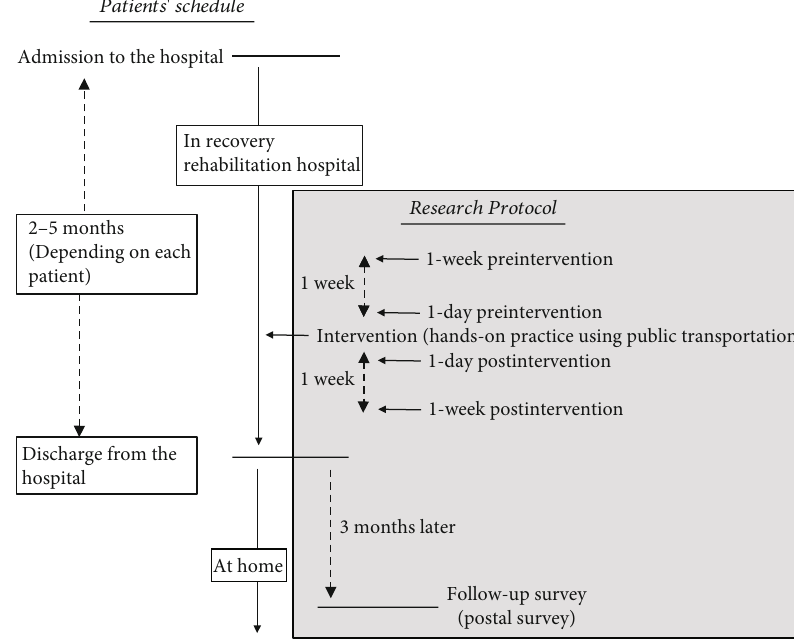
Figure 1: Patients ’ schedule and the research